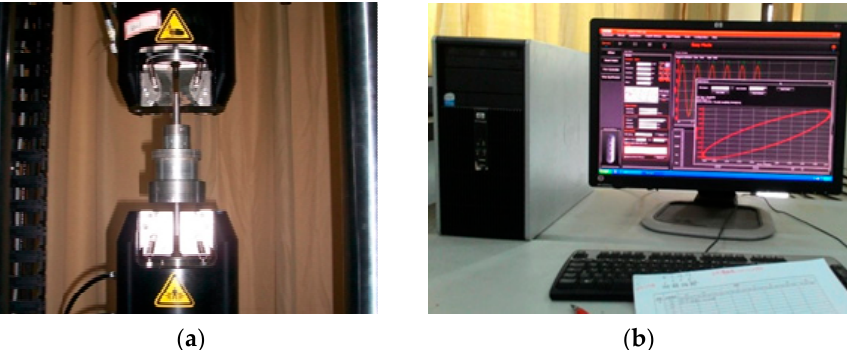
Figure 4. Test setup of viscoelastic dampers: ( a ) loading device and ( b ) data acquisition system.